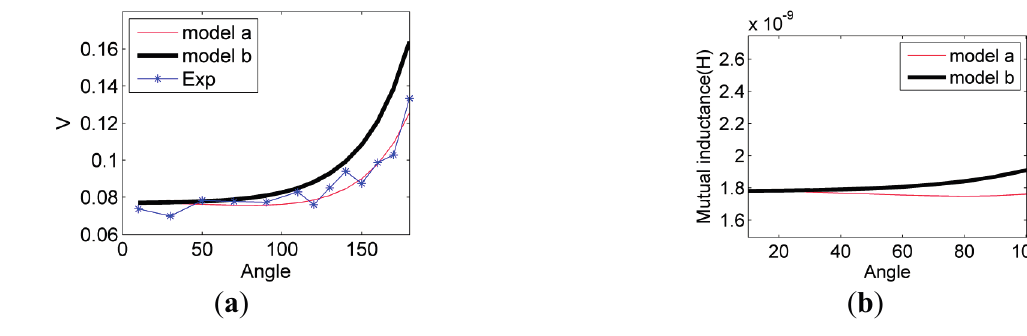
Figure 18. Results of arc distance to be 2.5 cm: ( a ) Comparison of experiment and simulation; ( b ) A closer look of two